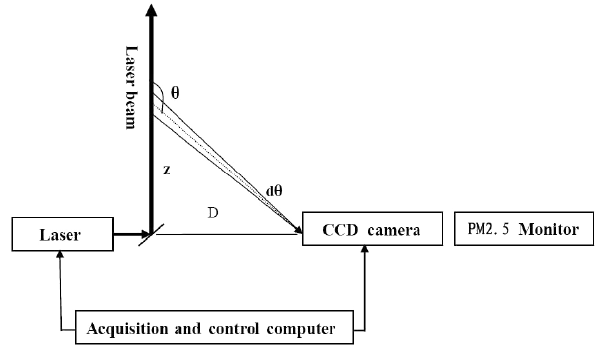
Figure 1. The diagram of the measurement system. Table 1. The specifications of the C-lidar